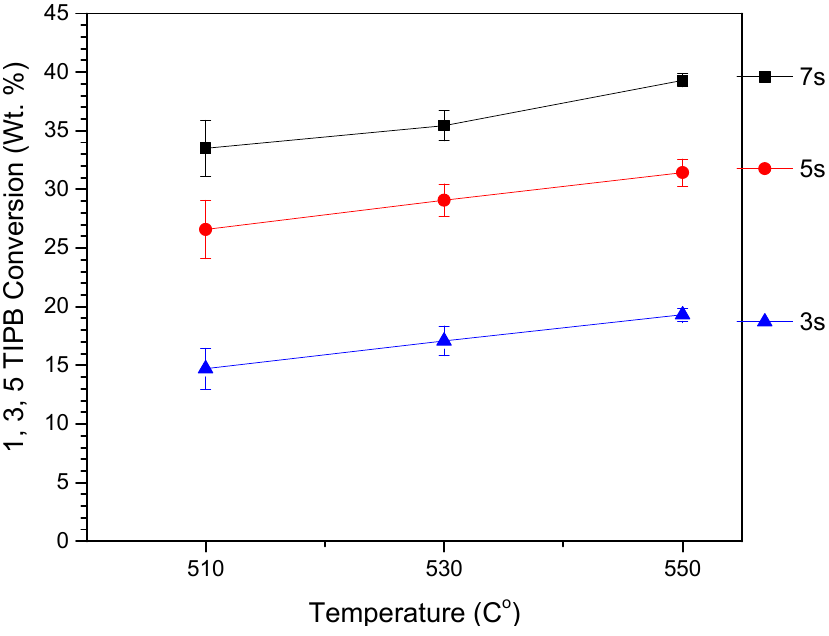
Figure 6. Effect of temperature and reaction time on the conversion of 1,3,5-TIPB using CAT-A. The C/O ratio was set to 2.5. Reported data and standard deviations (vertical bars) represent experimental data for at least five repeats.